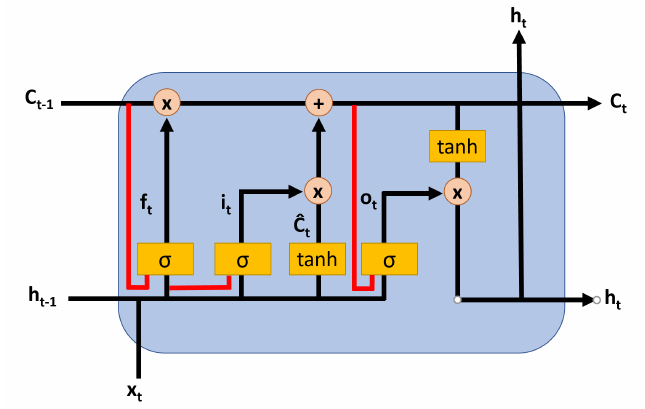
Figure 2. Structure of a ConvLSTM memory